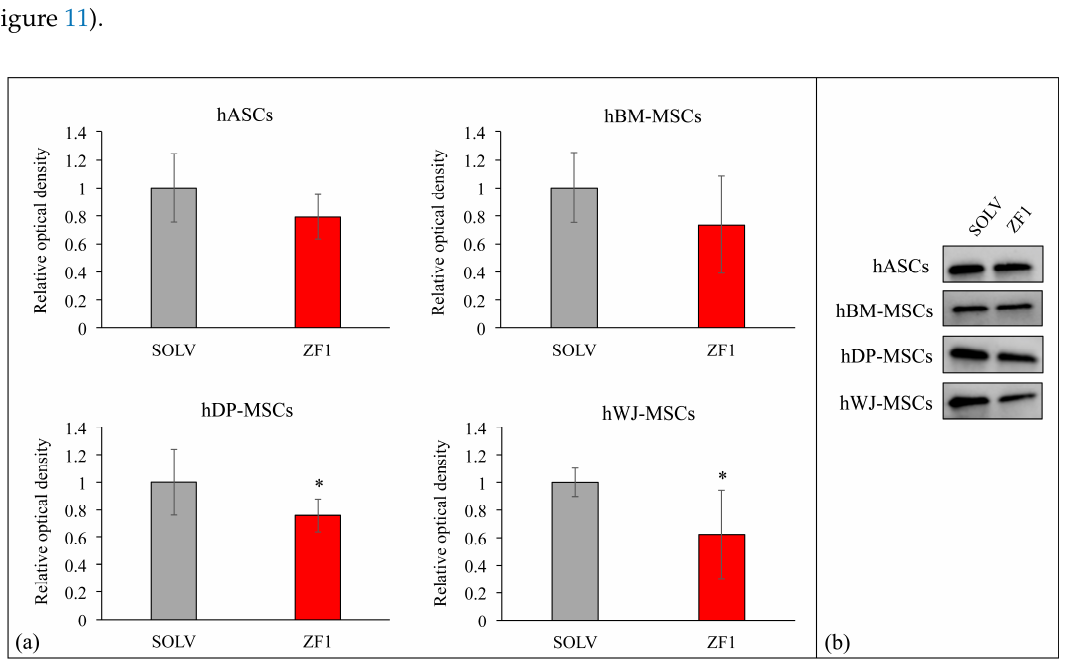
Figure 11. The Western blot analysis of p21 expression in SOLV- (as a control) and ZF1-treated hMSCs. ( a ) The graphs show the comparison of relative densitometric values of the bands normalized to total protein detected in stain-free acquisition in control (mean ± SD, statistical significance was evaluated using the Student’s t -test, * p < 0.05, n = 3). ( b ) Representative images of the Western blot for each investigated cell type.